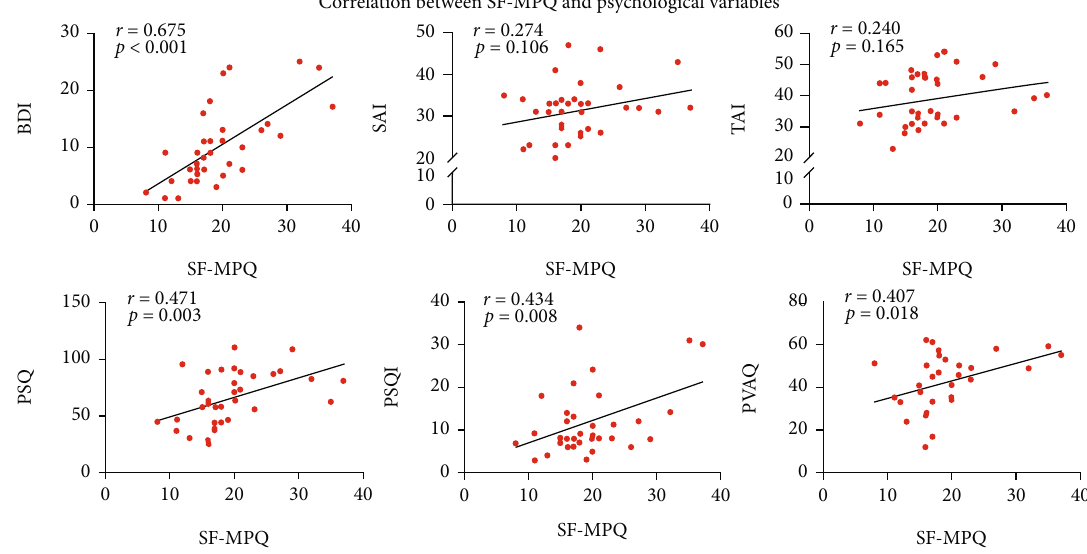
Figure 2: Correlation between pain intensities and psychological variables in LDH patients. (a) SF-MPQ ratings were signi fi cantly correlated with BDI, but not with SAI and TAI in LDH patients. SF-MPQ: short form of the McGill Pain Questionnaire; BDI: Beck- Depression Inventory; SAI: state-anxiety index; TAI: trait-anxiety index. (b) SF-MPQ ratings were signi fi cantly correlated with PSQ, PSQI, and PVAQ in LDH patients. PSQ: pain sensitivity questionnaire; PSQI: Pittsburgh sleep quality index; PVAQ: pain vigilance and awareness questionnaire.